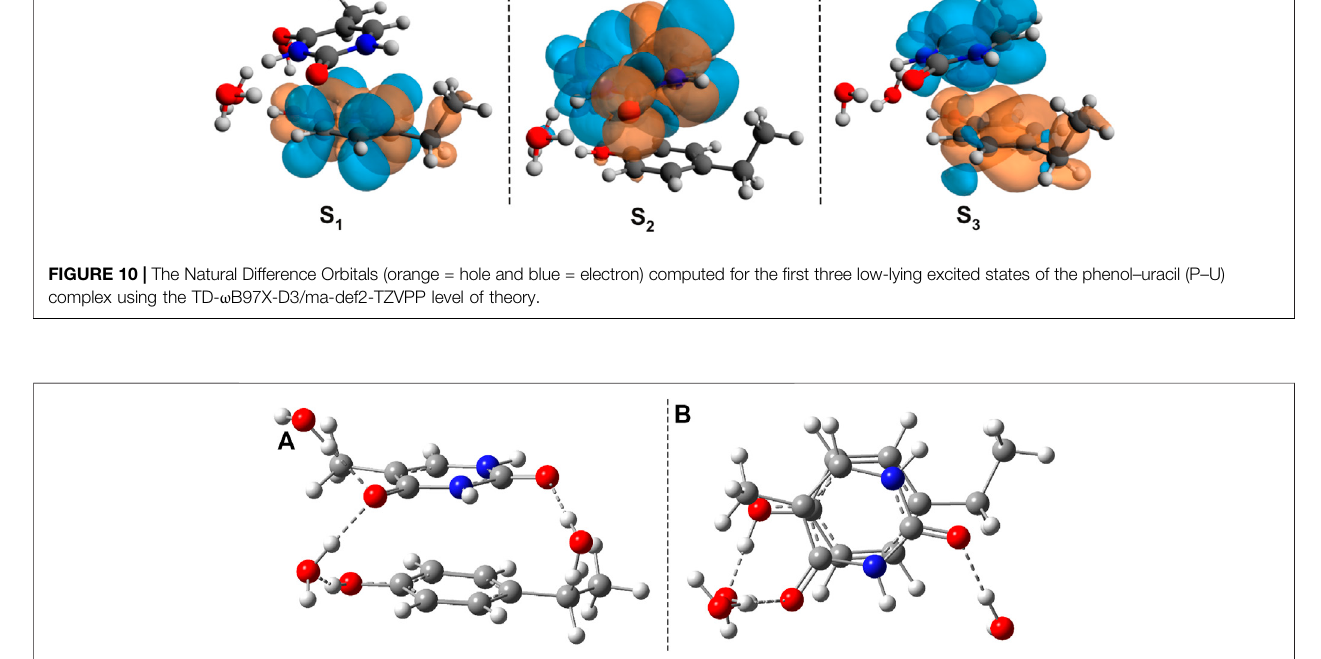
FIGURE 11 | Side (A) and top views (B) of the S 1 excited-state equilibrium geometry con fi guration of phenol – uracil (P – U).